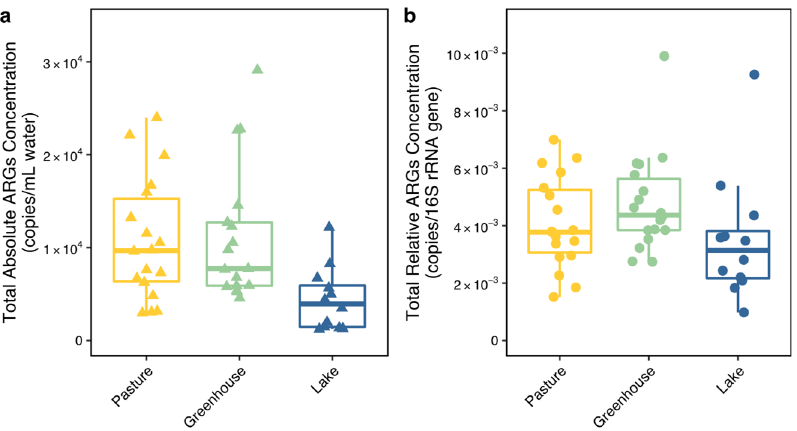
Figure 2. ARG concentrations. (a) Average of the relative concentrations [log 10 (x*10 8 +1) transformed, copies/16S rRNA gene] of each ARG in all 48 samples, with error bars on the top showing the stand- ard errors (SE). Colors indicate ARGs, each color family represents an antibiotic class, sulfonamide (yellow), trimethoprim (red), tetracycline (blue), beta-lactamase (green) and multidrug (grey). (b) Relative ARG concentrations (copies/16S rRNA gene) of each sample. Row names indicate the land use type of the sampling location (P, pasture; G, greenhouse; L, lake) followed by the number of the sequence of locations and replicates, e.g., P1 (the first pasture location)-1 (the first sampling replica- tion). Colors indicate ARGs in the same way as in (a) .